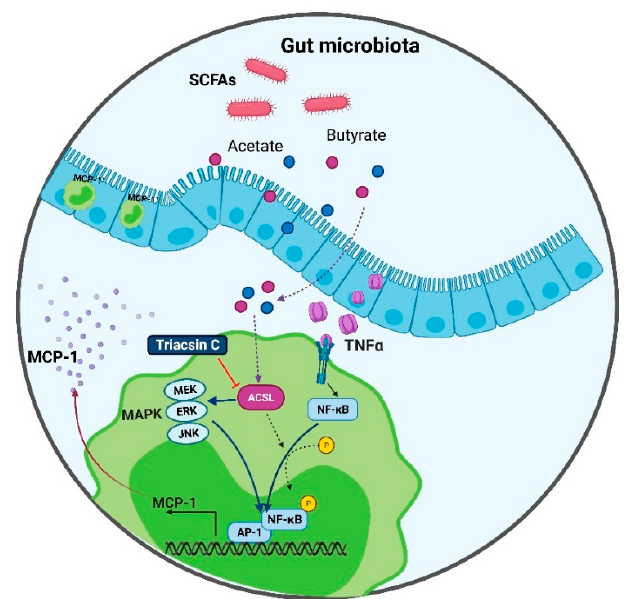
Figure 9. Schematic illustration of signaling pathway underlying the cooperative relationship be- tween acetate and TNF- α for MCP-1 production.